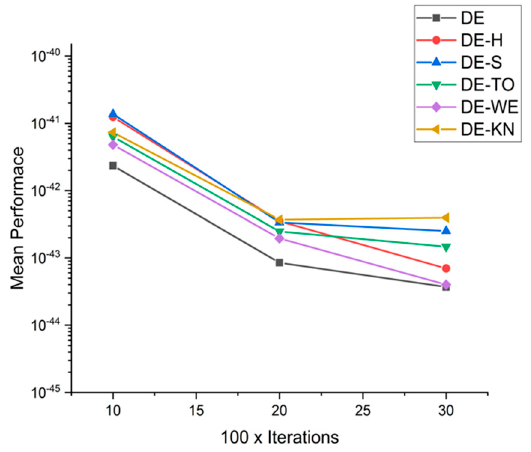
Figure 32. Convergence curve on fn10.